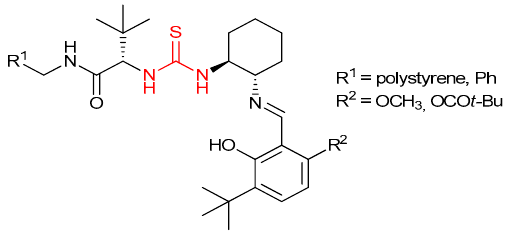
Figure 5. Jacobsen’s thioureas derived from 1,2-diaminocyclohexane [123–125].